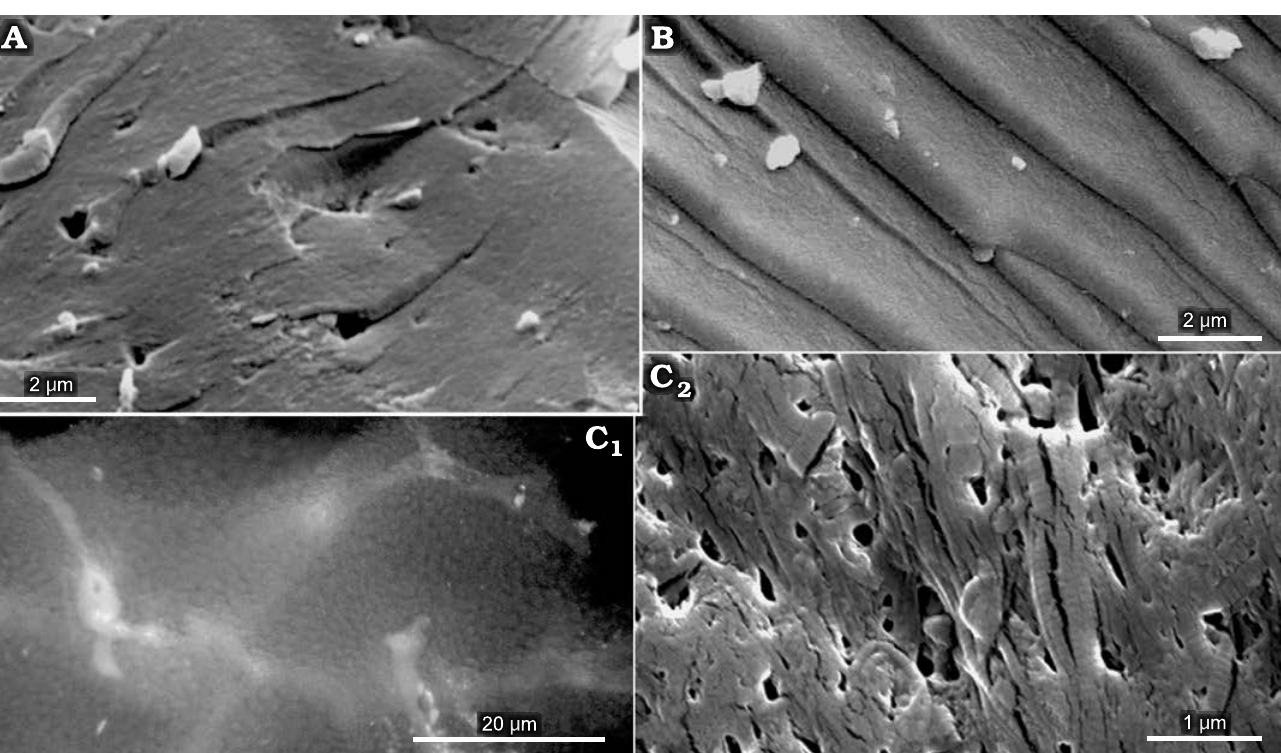
12. The comparative ultrastructural data. A . The hypothesized “beaks of Phragmoteuthis bisinuata ” (GBW 2006/011/0009, lower Carnian, Upper Triassic; Cave del Predil, NE Italy). B . Chitin of the lower beak of Lunzoteuthis schindelbergensis Doguzhaeva, Summesberger, and Mutvei, 2006 (NHMW 2005z0005/0001, lower Carnian, Upper Triassic; Schindelberg, Lower Austria). C . A cartilage of the cranial capsule of Loligo vulgaris (Lamarck, 1798) (Recent; North Sea); C 1 , C 2 , a matrix containing the collagen fibers showing a banding pattern. SEM images, except C 1 which is taken with